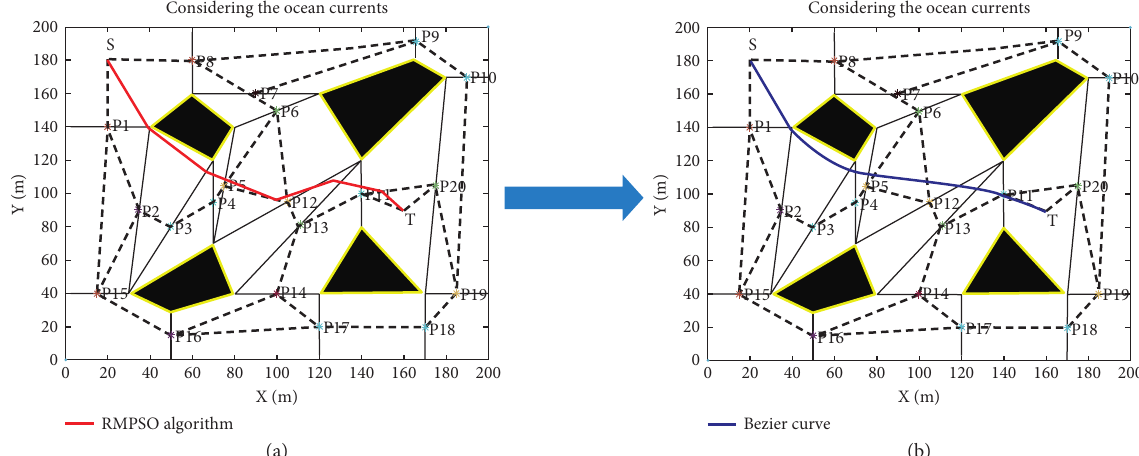
Figure 10: The influence of ocean currents is taken into account during path planning. (a) Path optimized by the RMPSO algorithm. (b) Path smoothed by the Bezier curve.